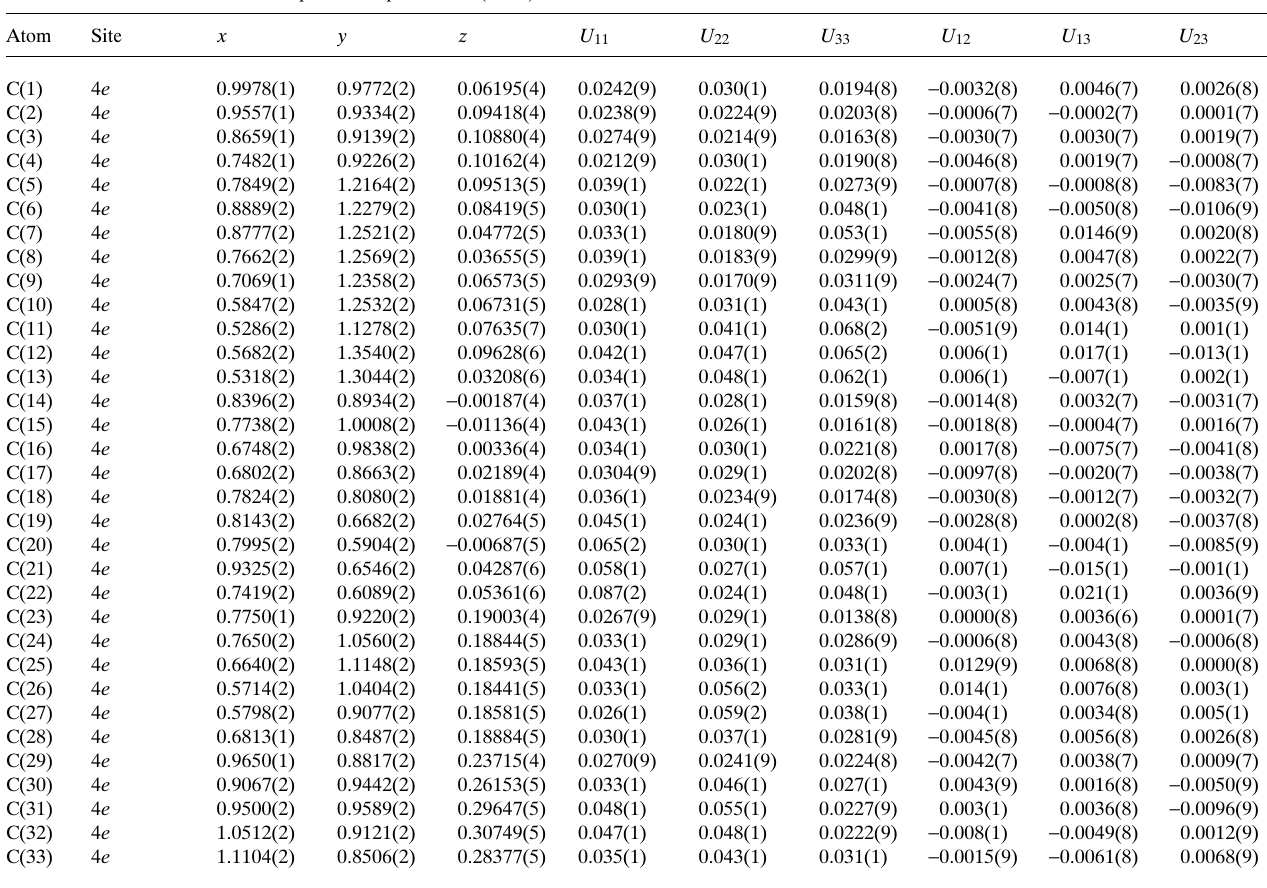
Table 3. Atomic coordinates and displacement parameters (in Å 2 ) .